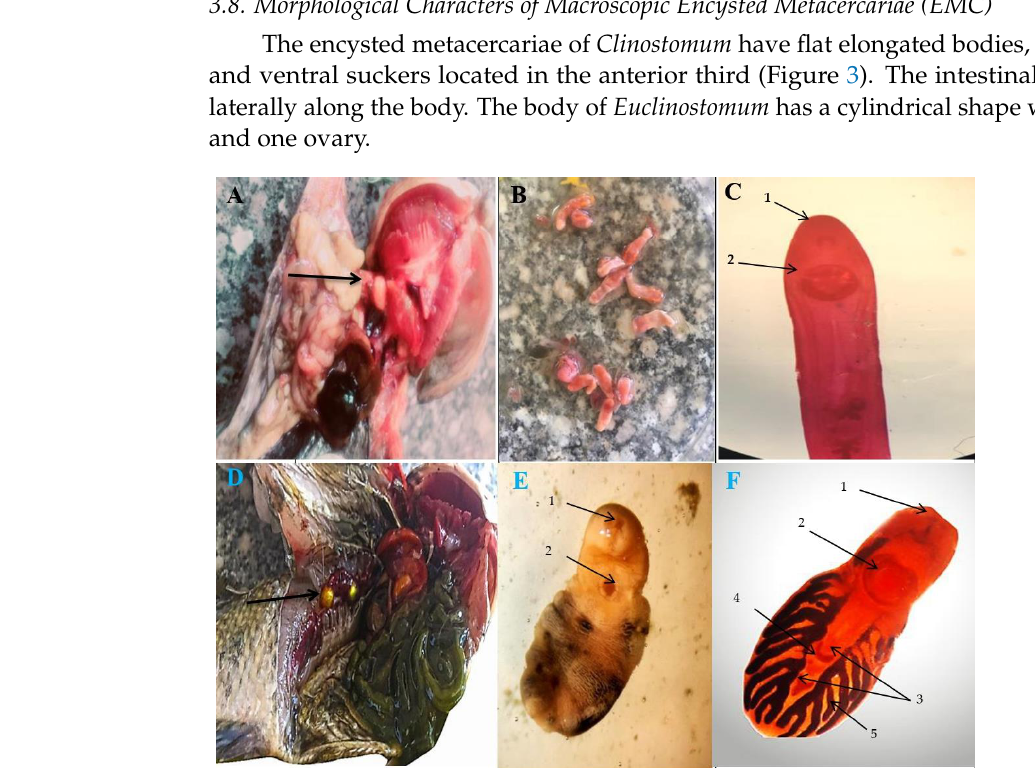
Figure 3. Macroscopic EMC of Nile tilapia. ( A ) Yellow nodule of Clinostomum EMC embedded in branchial arch of Nile tilapia (arrow); ( B ) excysted Clinostomum spp.; ( C ) Cli- nostomum spp. ×100 stained with acetic acid alum carmine (1 — oral sucker, 2 — ventral sucker); ( D ) metallic greenish cysts of Euclinostomum EMC embedded in kidney tissue; ( E ) excysted Euclinostomum spp.×20 (arrows show (1) oral sucker and (2) ventral sucker); ( F ) Euclinostomum spp. stained with acetic acid alum carmine ×40 (arrows show (1) oral sucker, (2) ventral sucker, (3) testes (4) ovary and (5) laterally branched ceca. 3.9. Morphological Characters of Microscopic Encysted Metacercariae (EMC) As shown in Figure 4, the encysted metacercariae of Prohemistomum vivax have a spherically shaped body, are double walled and have a thick outer and inner hyaline wall branched with pigmented granules. The encysted metacercariae of Centrocestus spp. have an elon- gated elliptical body, an oral sucker surrounded by spines arranged in two rows and an x-shaped excretory bladder. The encysted metacercariae of Echinostoma have an oval- shaped body and possess collar spines and corpuscles in their excretory tubes. The en- cysted metacercariae of Diplostomum have an elongated body with a subterminal oval- shaped oral sucker and a subspherical ventral sucker.